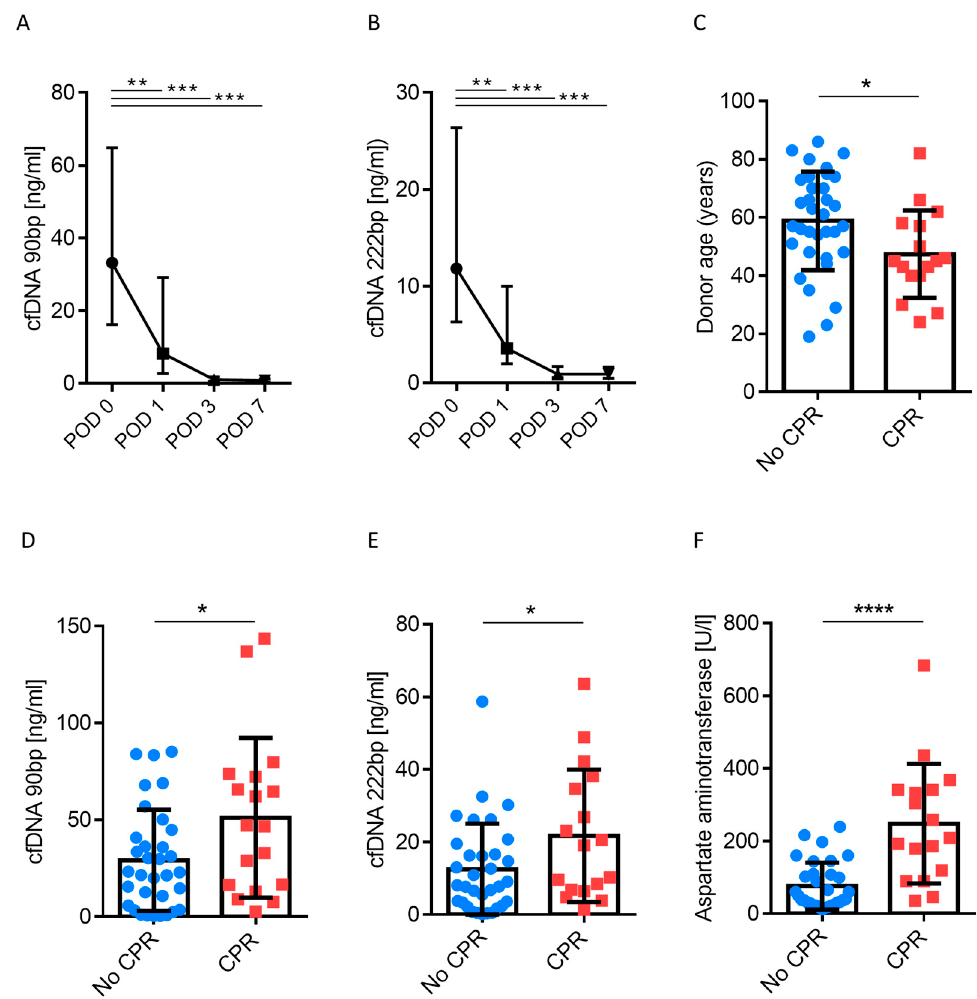
Figure 1. ( A , B ) Cell-free DNA (cfDNA) time course (90 bp and 222 bp L1PA2 element, human long interspersed element (LINE) sequence, non-coding) in serum in patients after liver transplantation ( n = 50). Samples were taken when patients were admitted postoperatively to the intensive care unit. ( C − F ). Donor age and laboratory values analysed according to cardiopulmonary resuscitation (CPR). Mann–Whitney U test; * p < 0.05; ** p < 0.01; *** p <